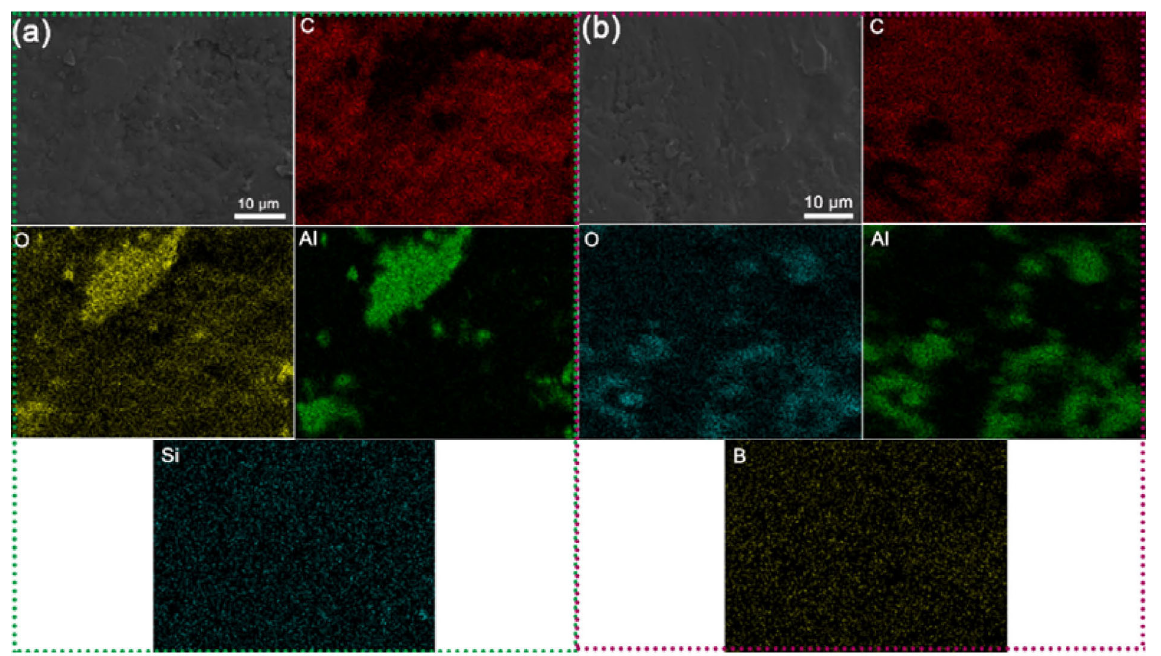
Fig. 9 Tribofilms and corresponding elemental mappings generated from (a) PI/AP/SiO 2 and (b) PI/AP/BN for sliding against Al 2 O 3 at 4